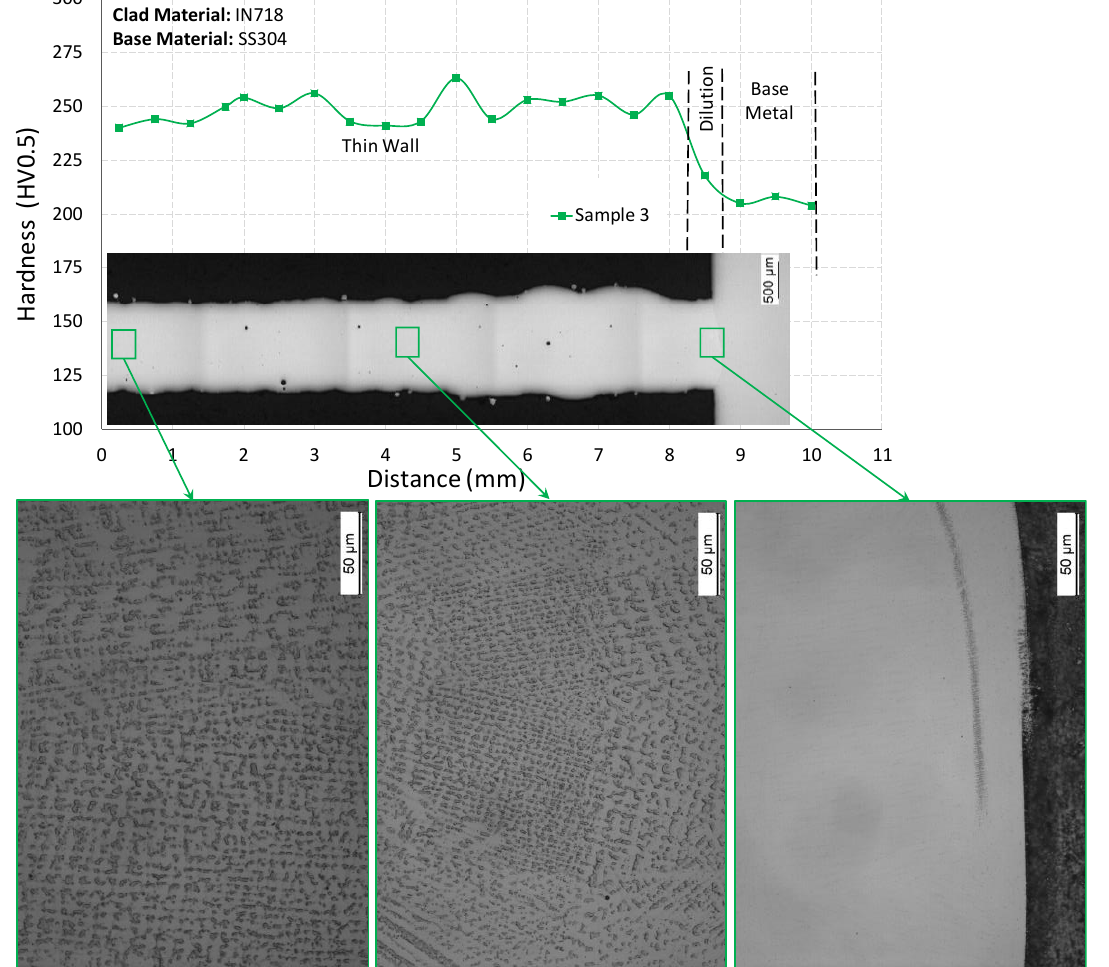
Figure 15. Microhardness profile on the wall manufactured with IN718 (sample 3) and the microstructure in each area of the wall.